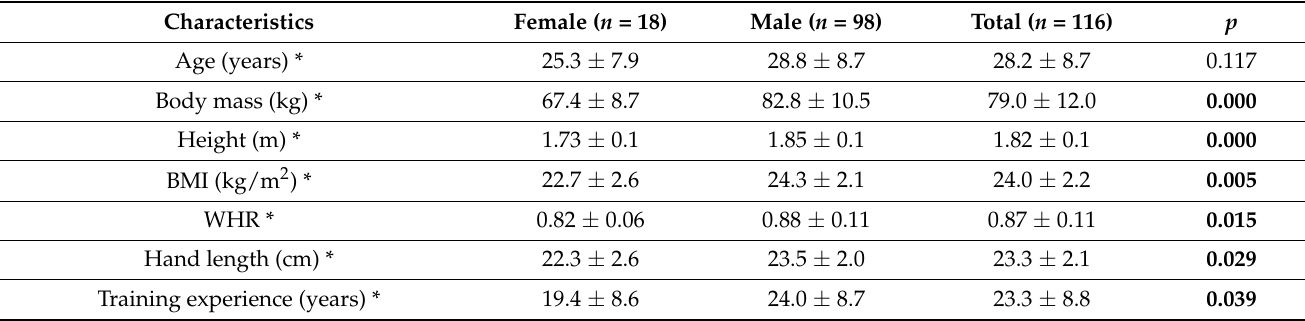
Table 1. Elite rink-hockey players’ characteristics ( n = 116, 18 females and 98 males).